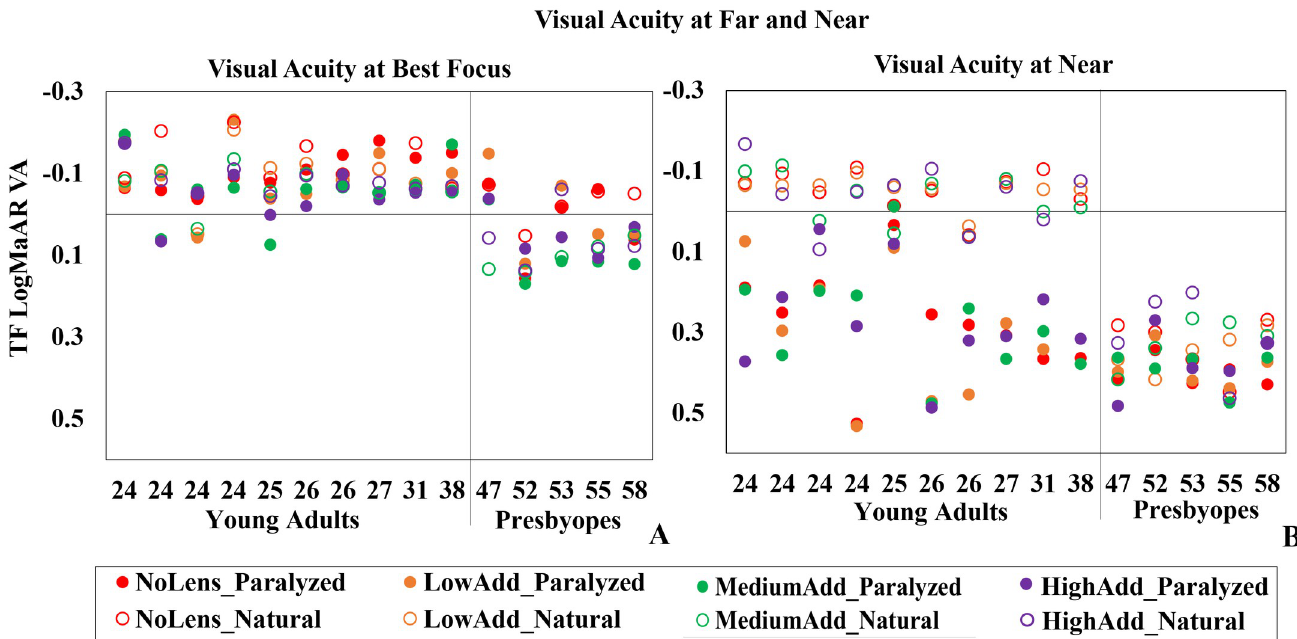
Fig 2. logMAR VA at far and near. (A) logMAR VA at far and (B) logMAR VA at near, for all lenses and conditions, as a function of subject’s age. Different lenses are identified by color—Red: NoLens; Orange: LowAdd; Green: MediumAdd; Purple: HighAdd. Solid symbols stand for paralyzed accommodation and open symbols for natural accommodation. Subjects to the left of the separation bar are young adults; and to the right of the separation bar are presbyopes.